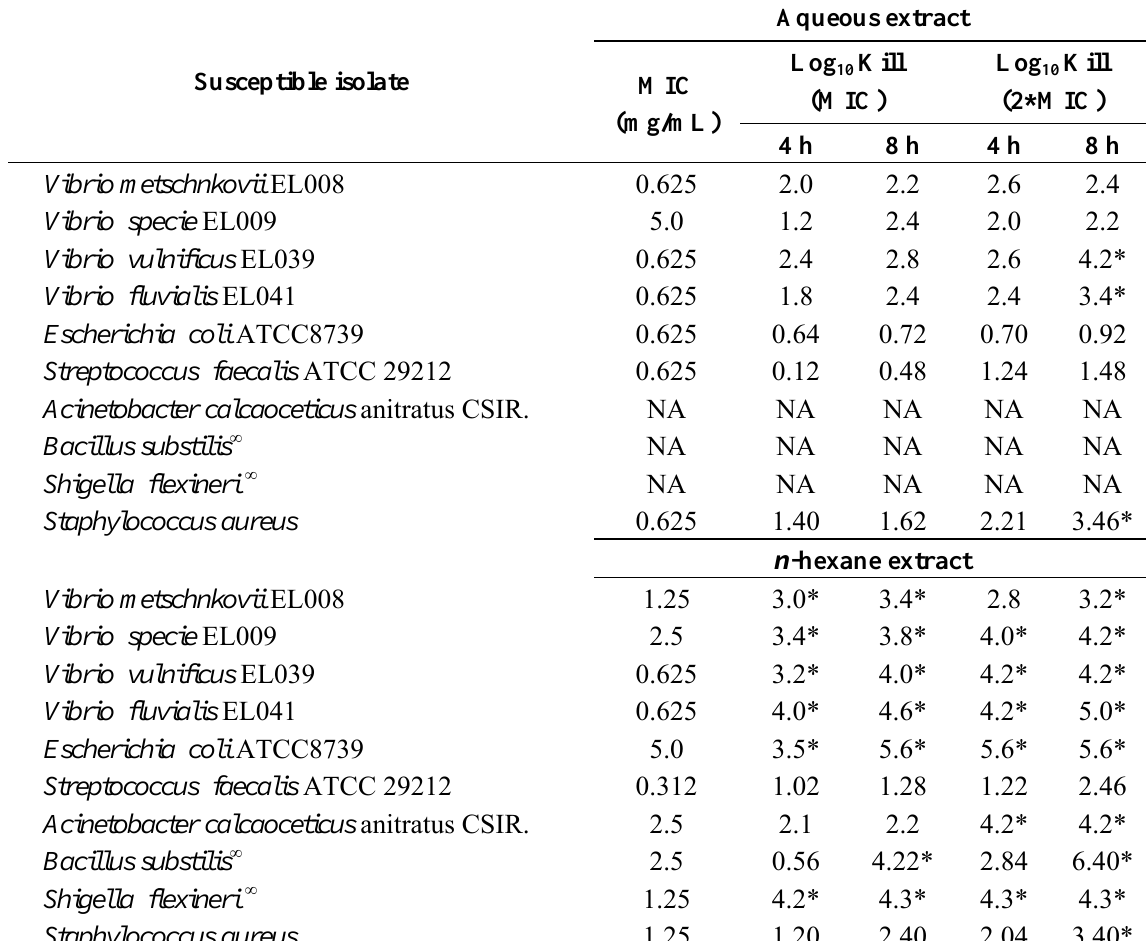
Table 3. Nature of inhibition of crude aqueous and n -hexane extracts of C. nucifera husk against some bacterial isolates and Vibrio